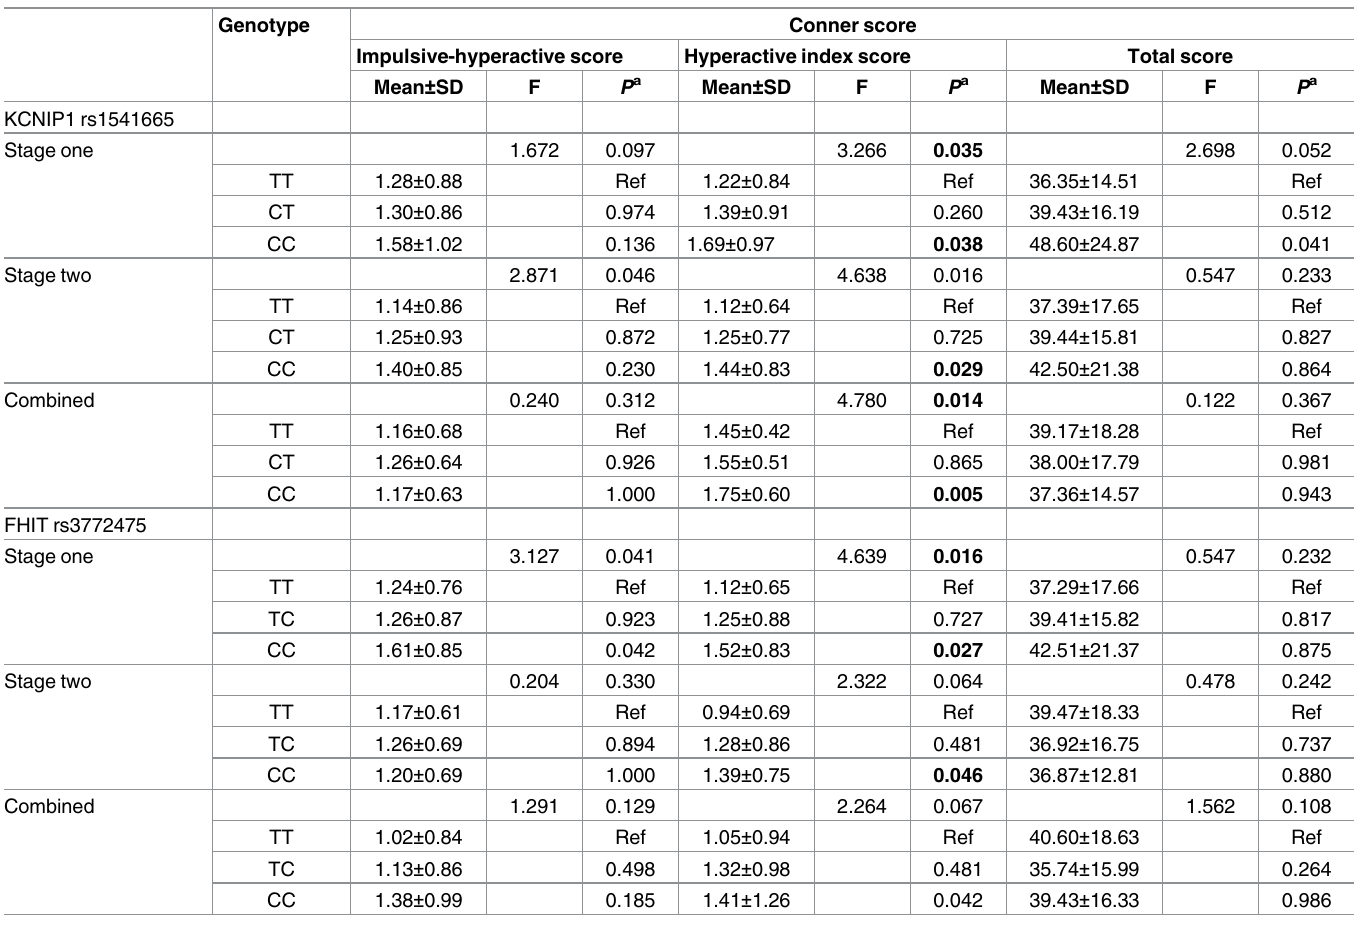
Table 4. Association of promising SNPs genotypes with PSQ scores in all